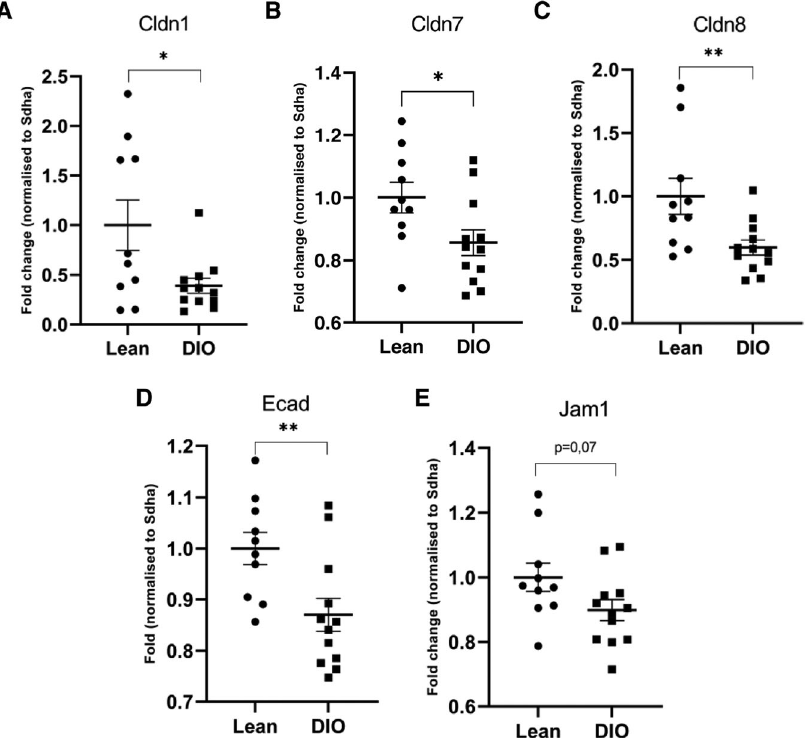
Fig. 3 Tight junction and adhesion protein gene expression in the lean and obese mice. The jejunum was sampled from the two diet groups, lean mice on a low-fat diet (LFD) and obese mice on a high-fat diet (DIO) ( n = 10 – 12/grp). qPCR analysis was performed for selected tight junctions ’ genes ( A ) Claudin 1, ( B ) Claudin 7, ( C ) Claudin 8, ( D ) E-cadherin, and ( E ) Junctional adhesion molecule and normalized to succinate dehydrogenase complex (Sdha). Unpaired two-tailed t test. * p < 0.05, ** p <